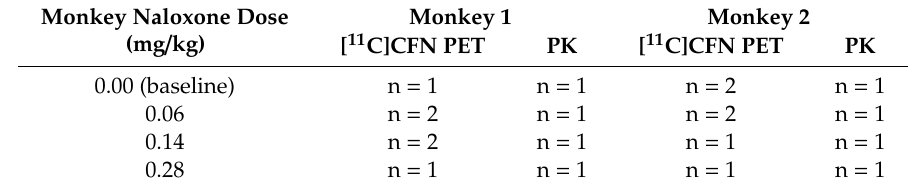
Table 2. Naloxone dosing [14]. Figure 1. Representative transverse (top row), sagittal (middle row), and coronal (bottom row) monkey positron emission tomography (PET) images of a [ 11 C]CFN baseline scan and following blocking studies with low (0.06 mg/kg), medium (0.14 mg/kg), and high (0.28 mg/kg) doses of